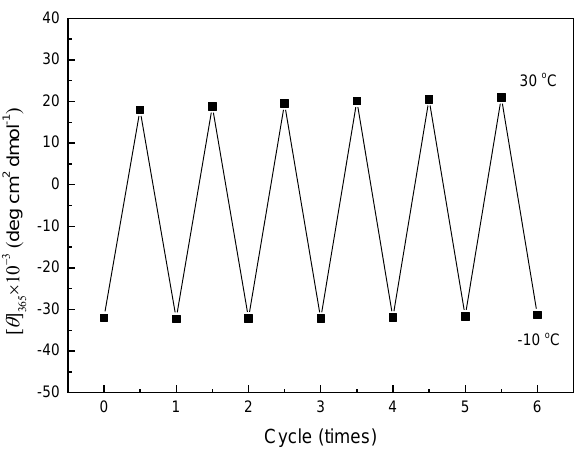
Figure 5. Plots of the [ θ ] 365 values of PPAA-Val in chloroform upon continuous thermocycling (−10–30 °C) in CHCl 3 ( c = 1 mg/mL).